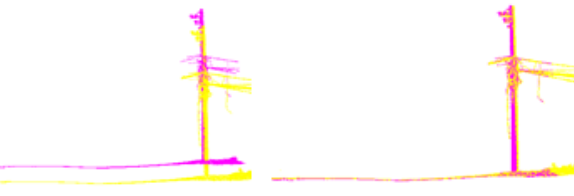
Figure 11. Vertical differences before and after the registration process.